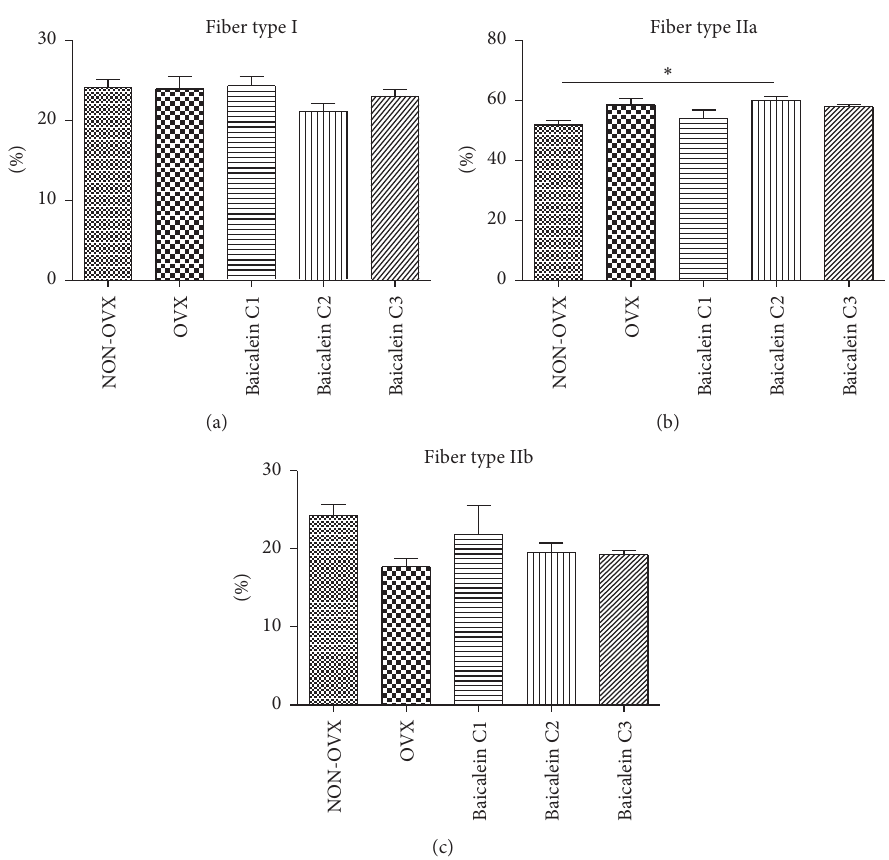
Figure 7: Rate of M. longissimus fibre types I, IIa, and IIb. In M. longissimus, the distribution of fibre type I was not significantly different among the groups ((a), 𝑛 = 46 ). Fibre type IIa was significantly more or expanded in the C2 group versus the NON-OVX group ((b), 𝑛 = 46 ). A significant increase in IIb muscle fibres was seen in the NON-OVX group when compared with the C2 group ((c), 𝑛 = 46 ). ∗ 𝑝 < 0.05 indicates significant